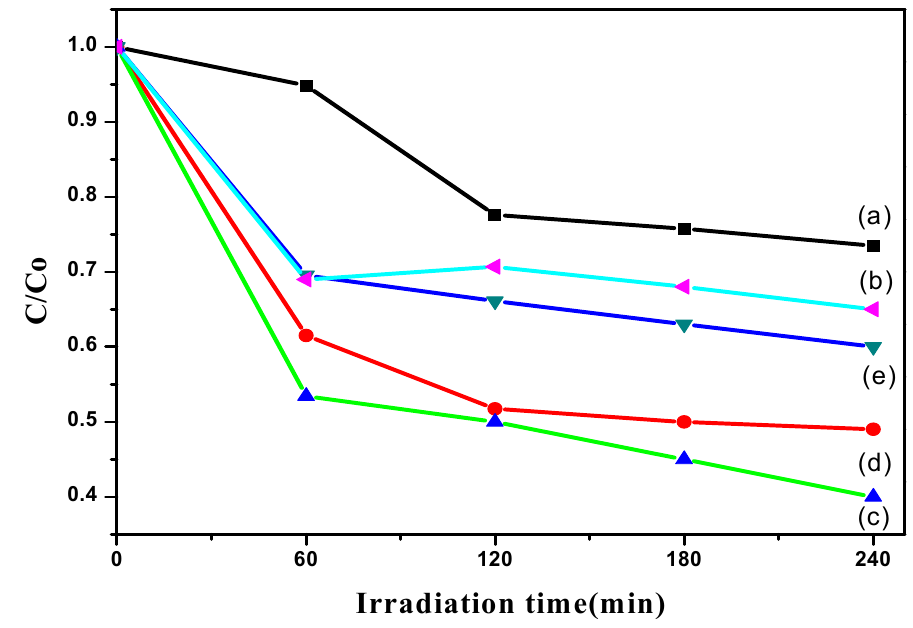
Figure 7. Plot of the C/Co vs. irradiation time of ( a ) TiO 2 without heat treatment and heat-treated TiO 2 nanotubes anodized at an anodization time of ( b ) 30 s; ( c ) 10 min; ( d ) 20 min and ( e ) 60 min.